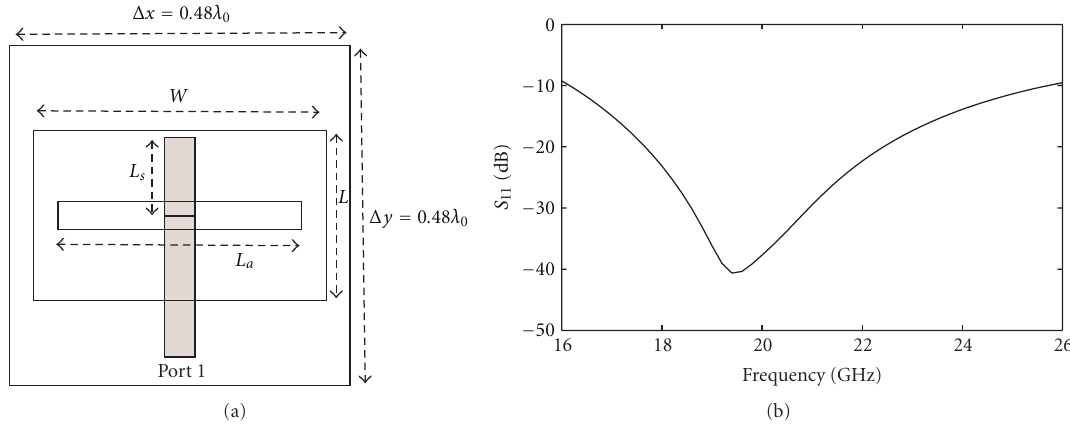
Figure 14: Aperture-coupled reflectarray unit cell—(a) top view and (b) simulated return loss at port